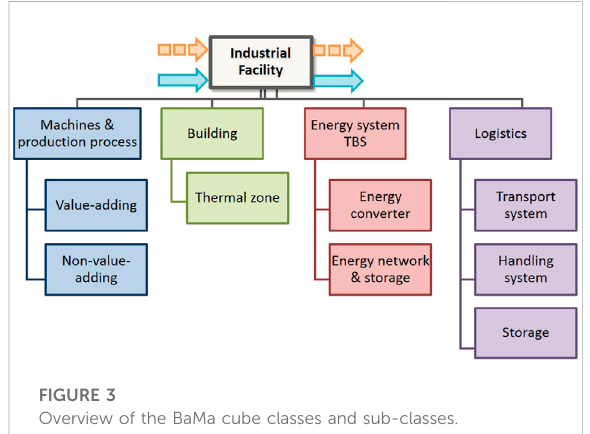
FIGURE 3 Overview of the BaMa cube classes and